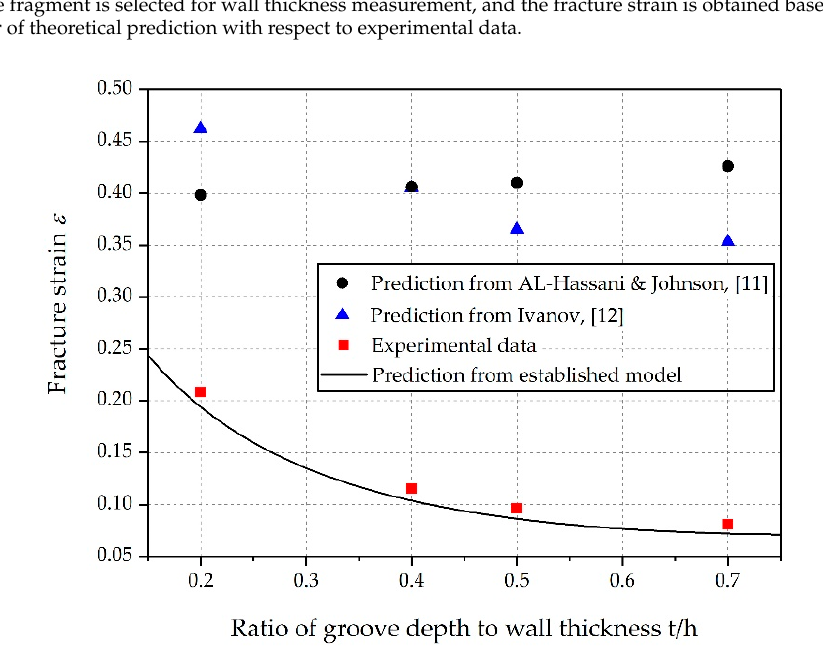
Figure 19. Fracture strain of explosively driven cylindrical shells with varied groove depths.